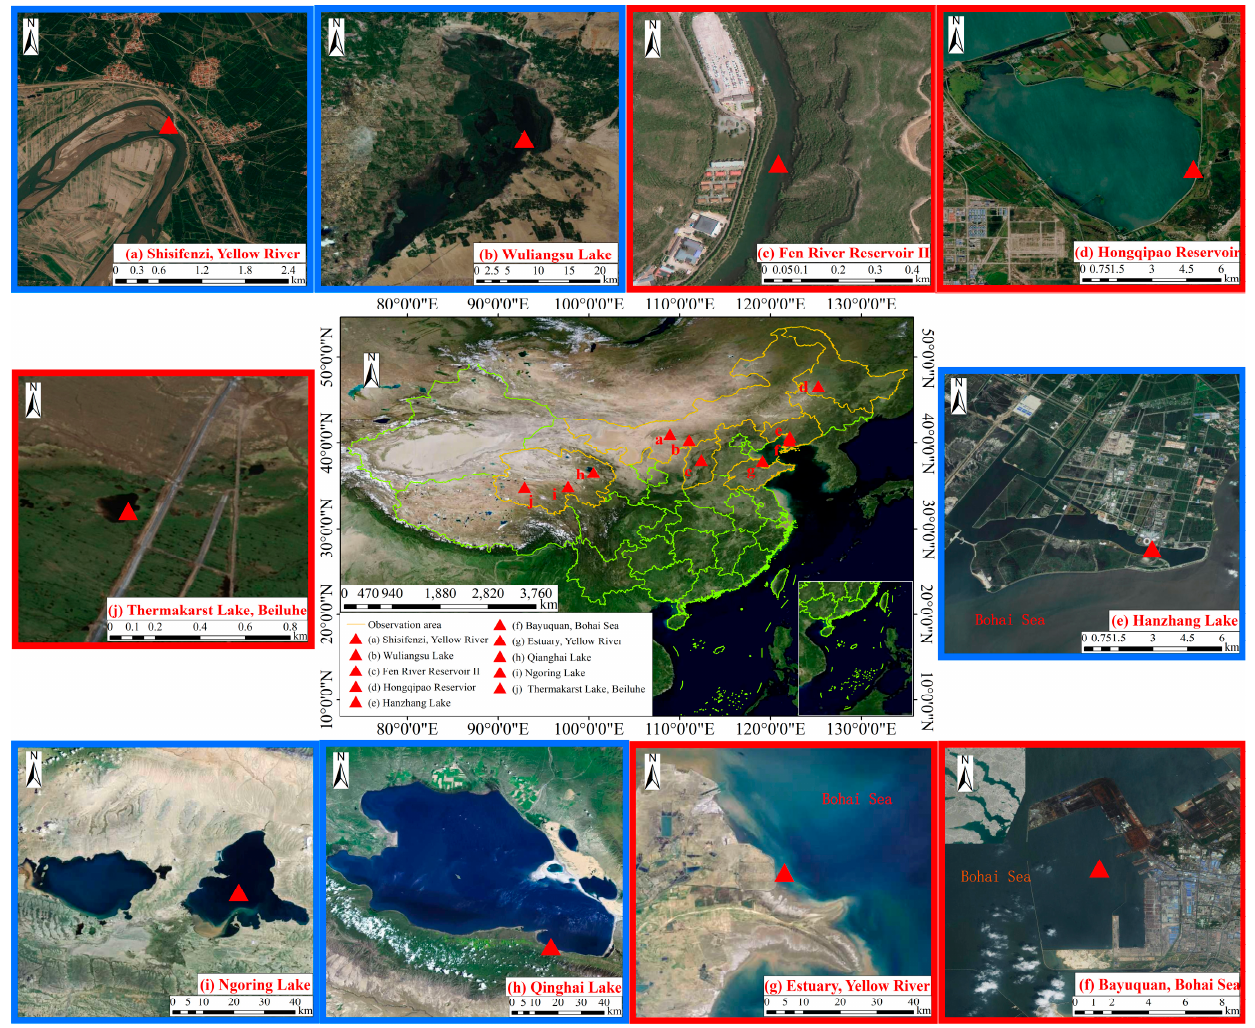
Figure 1. Site locations of a time-series survey of vertical temperature distribution within different ice layers in China (the red boxes indicate that the research on the thermal properties of ice has been carried out, and the blue boxes indicate that the research has not been carried out).